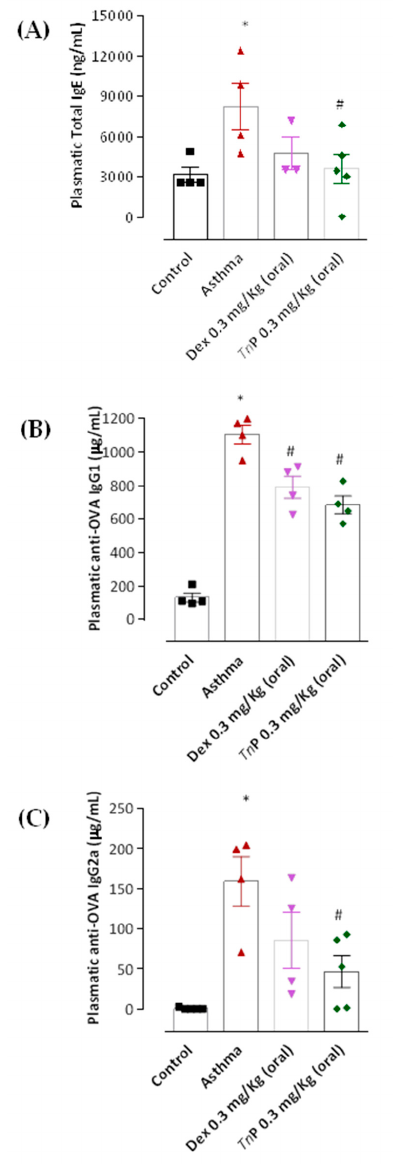
Figure 4. Effect of Tn P on anaphylactic antibody titers. Twenty-four hours after the last aerosol challenge, mice from the control, asthma, Tn P, or Dexa groups were bled for total ( A ), specific-OVA IgG1 ( B ), and specific-OVA IgG2a ( C ) determination by ELISA. The results represent the mean ± SEM of 3–5 animals/group. * p < 0.05 compared to the control group and # p < 0.05 compared to the asthma group.